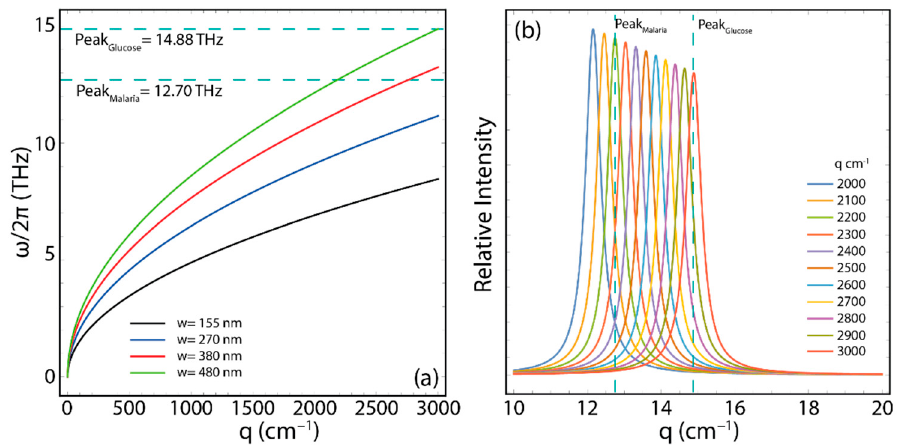
Figure 19. ( a ) Plasmon frequency dispersion ( ≤ 16 THz) ( ω /2 π ) vs. wave vector ( q ), considering different ribbons widths (155, 270, 380, and 480 nm). ( b ) Plasmon excitation lifetime for w = 480 nm, considering different momenta from 2000 to 3000 cm − 1 . The parameters of Equation (4) have been fixed as: N 2 D = 1.0 × 10 12 cm − 2 , θ = 0, and ν = 2.24 × 10 13 s − 1 . The plasmon spectra were calculated using the Lorentzian shape function to a maximum value of 1 with FWHM = 0.5 .